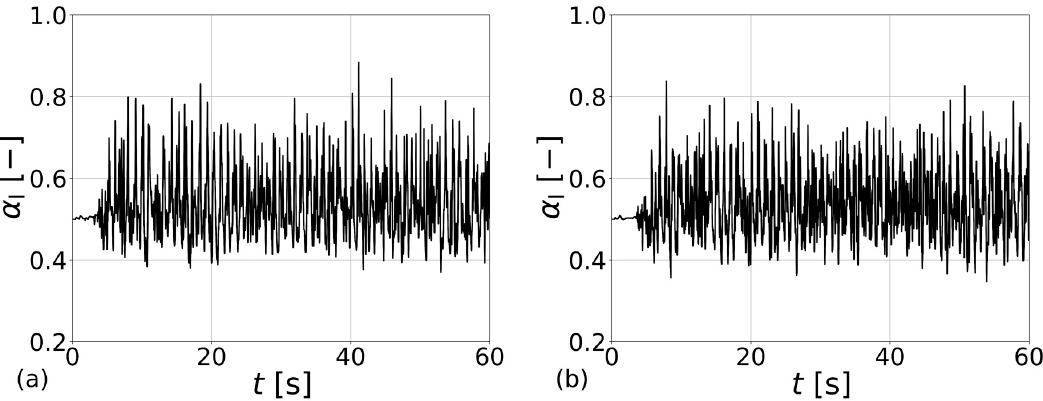
Figure 7. Time behaviour of the oil volume fraction on the annular cross-section. ( a ) coarse mesh; ( b ) fine mesh. ( b ) fine